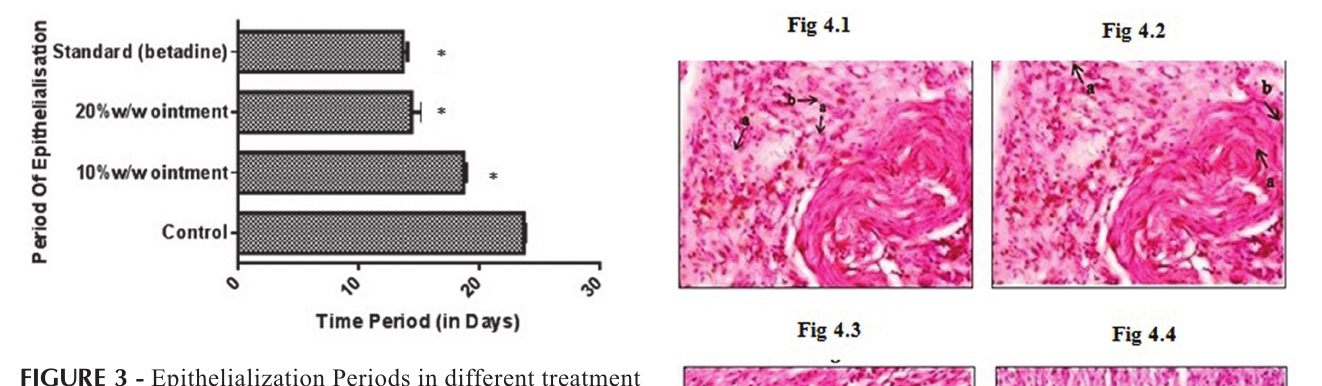
. The antimicrobial activity results are indicated in Table V and Figure 5. The ethanolic extract of HH has shown minimum inhibitory concentration at 125mg/mL against gram negative organism Escherichia coli.